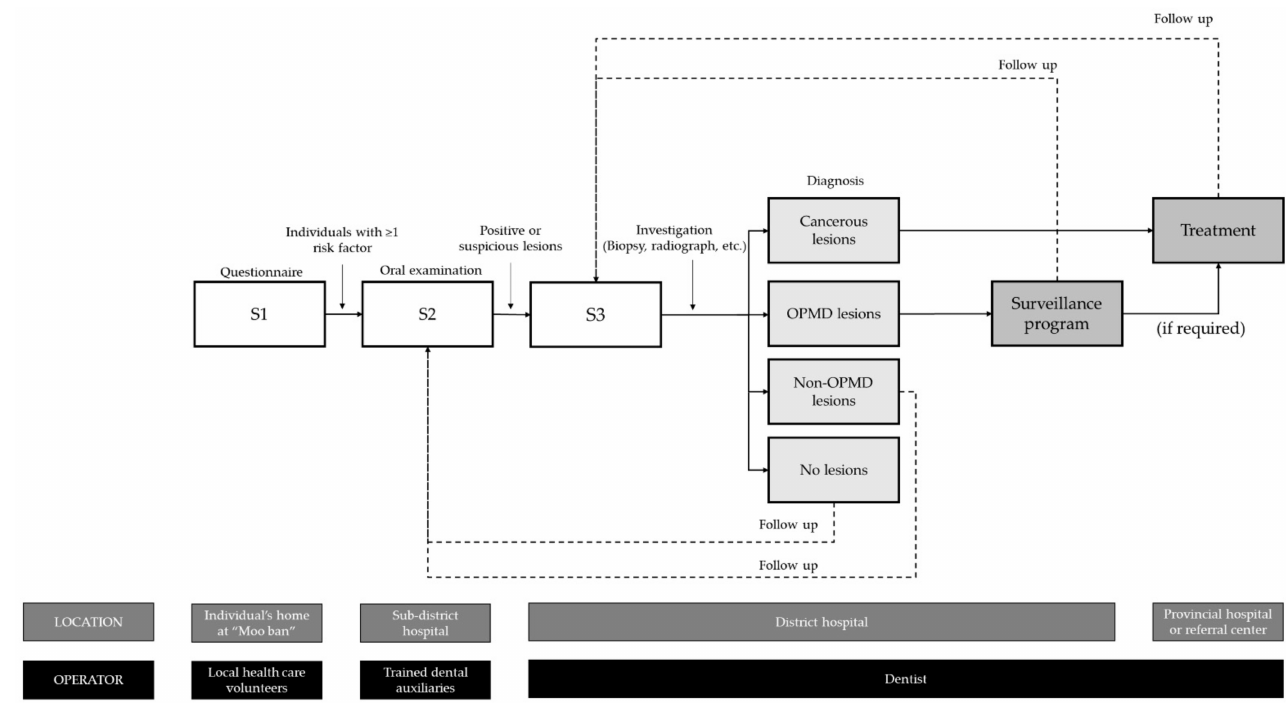
Figure 2. Screening methodology used in this study. OPMD = Oral potentially malignant disorder.